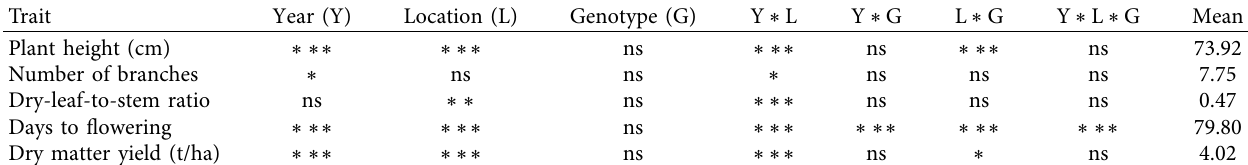
Table 2: Combined analysis of variance for agronomic traits of cowpea accession tested across two locations.